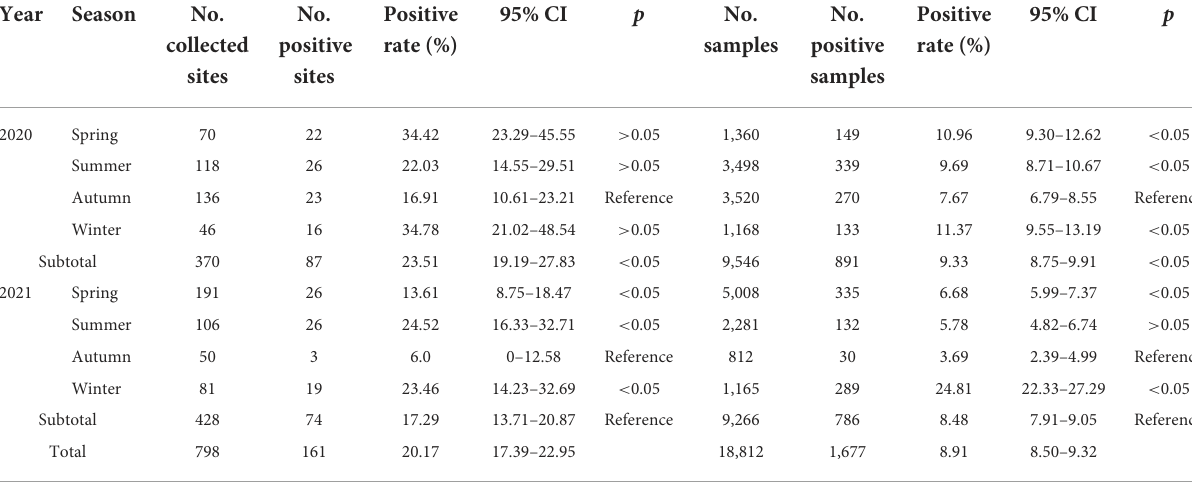
TABLE 3 Seroprevalence of PRV-gE in pig populations in Hunan Province during